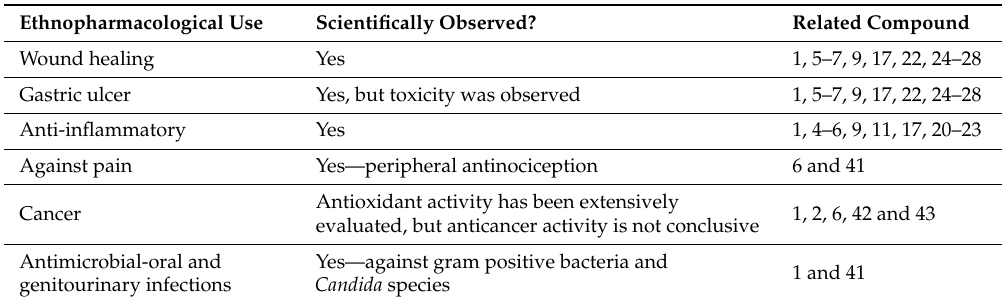
Table 3. Ethnopharmacological uses scientifically studied and correlated compounds (identified by their numbers in Table